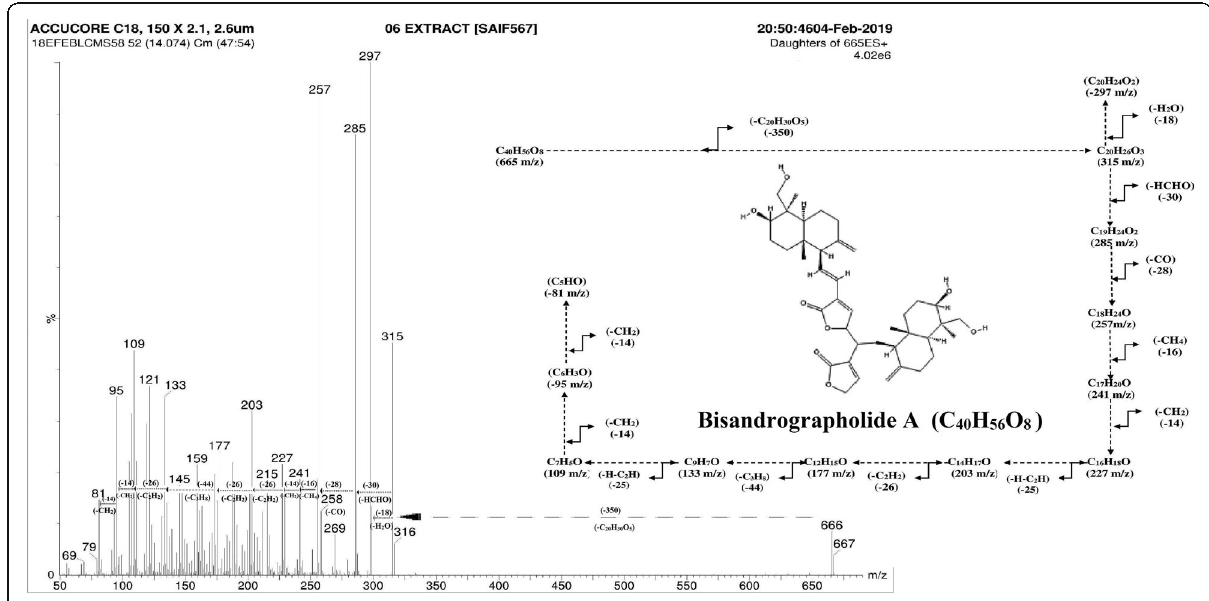
Fig. 10 Fragmentation pathway of Bisandrographolide